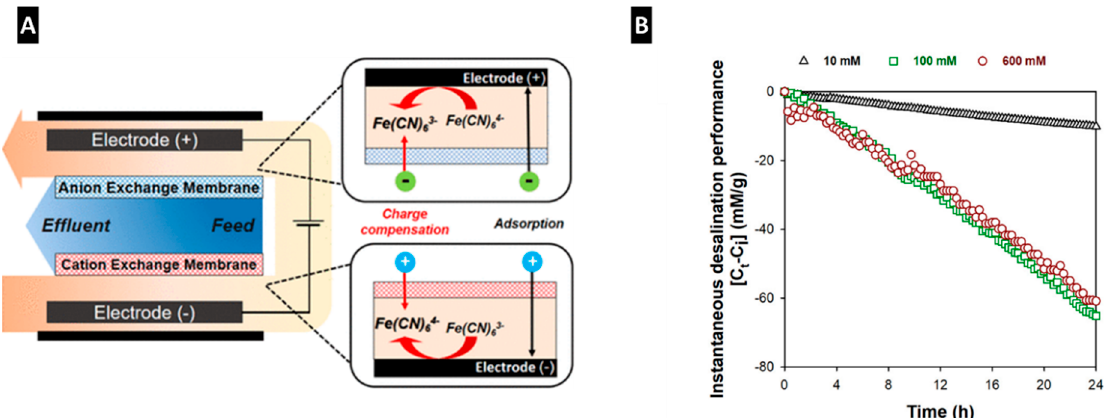
Figure 9. ( A ) Schematic illustration and ( B ) continuous desalination operation of CDI assisted by redox couple reaction (Reprinted with permission from [34]. Copyright (2019) American Chemical Society).